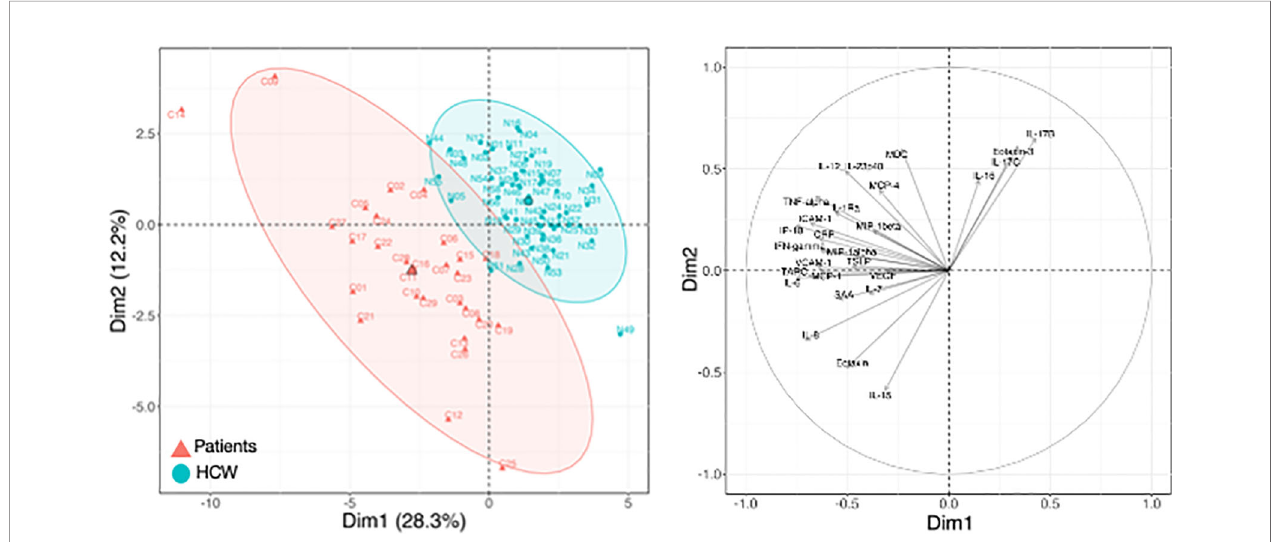
FIGURE 4 | Cytokine levels at pre-vaccination in patients and HCW. Comparison of serum cytokine levels pre-vaccination (d1) between patients (n=29) and healthy volunteers [n = 57, as reported in (21)]. PCA plot (left panel) distinguishes patients (red triangle) from HCW (blue circle) based on their cytokine levels at day 1, capturing 28.3% and 12.2% of the dataset variance along PC1 and PC2, respectively. Median from each group is depicted as larger symbol. PCA loading plot (right panel) showed how strongly cytokines (depicted as grey vectors) in fl uence both PC1 and PC2. The projection of the vectors on PC1 and PC2 corresponded to the loading value (weight) of the cytokine they